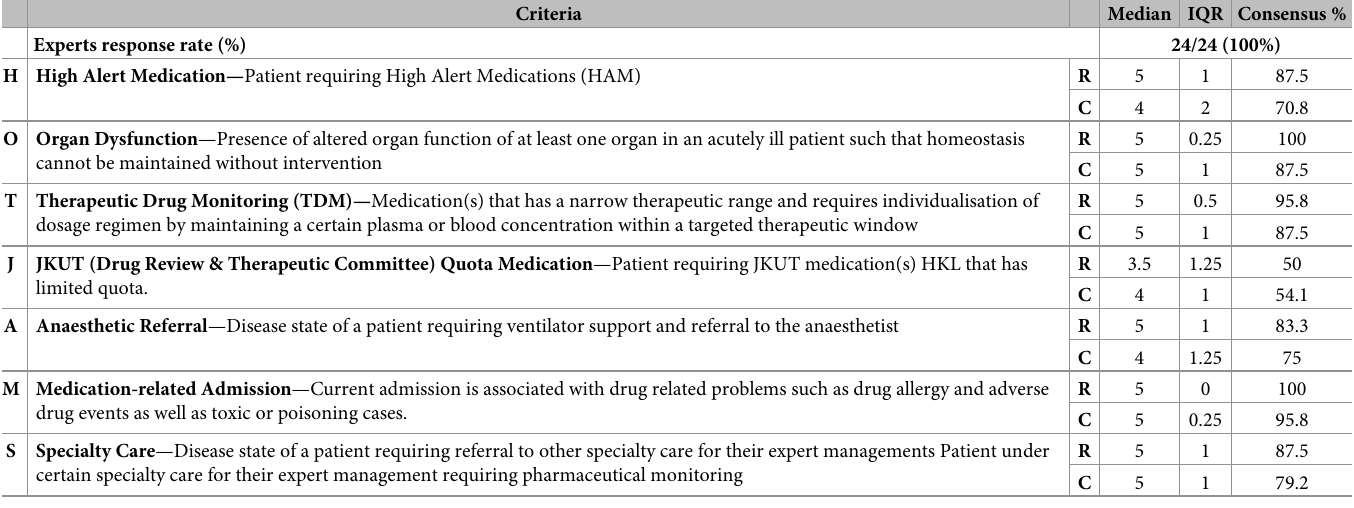
Table 2. Delphi round 1